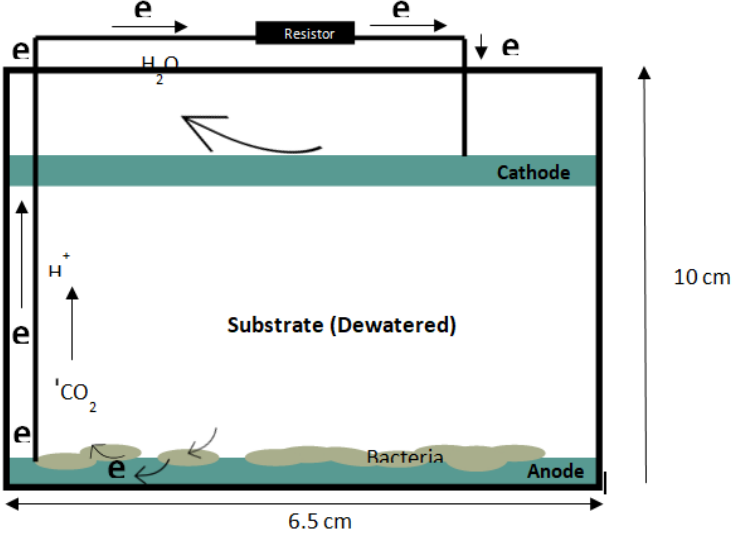
Figure 14. Illustration of membrane-less air cathode.